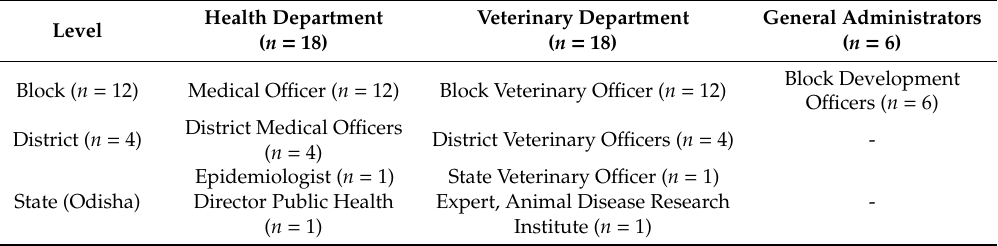
Table 1. Characteristics of the study participants.